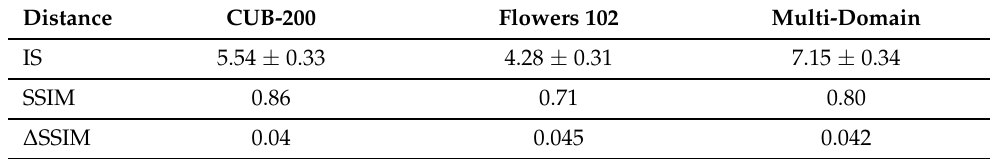
Table 1. The Inception Score (IS), the Structural Similarity Score (SSIM) and the ∆ SSIM (Equation (11)) are reported, respectively, for the generation of birds, flowers and their combined use. Distance CUB-200 Flowers 102 Multi-Domain IS 5.54 ± 0.33 SSIM